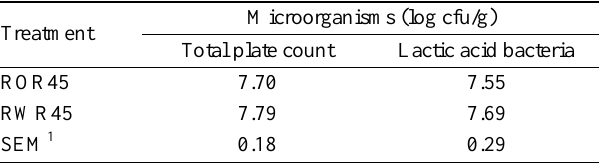
Table 3. Quantitative evaluation of total plate, coliform, and lactic acid bacteria counts in salchichon modified sausage after 45 d ripening and/or added rosemary powder